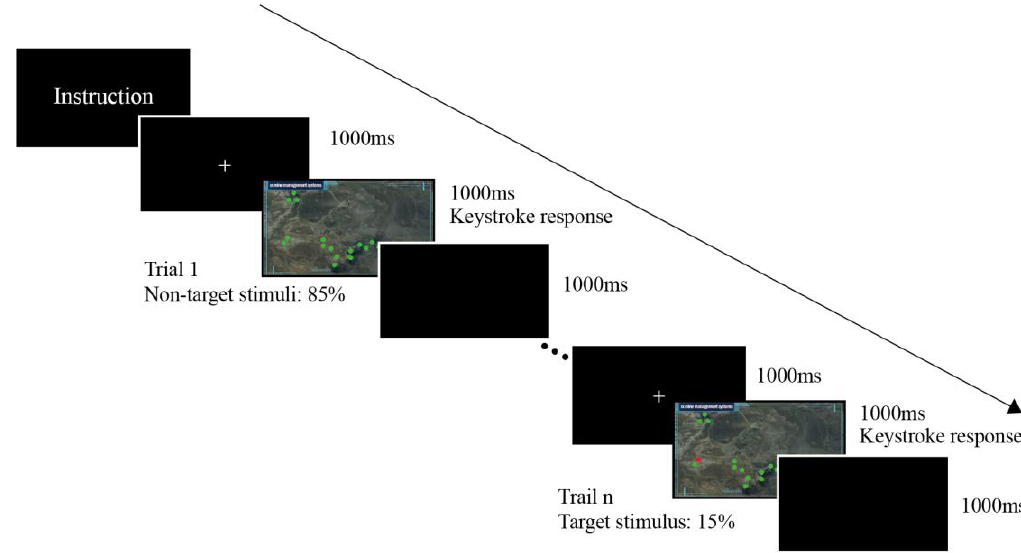
Figure 3. Early-warning interface oddball experiment flow.